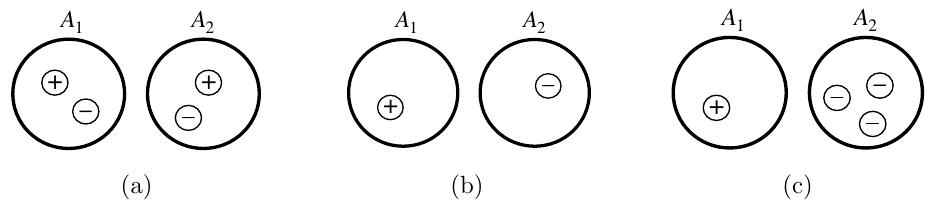
Figure 2. (a) Charge neutral operators in region A 1 [ A 2 : a 2 A 1 (cid:10) A 2 . (b) A bi-local intertwiner in A 1 [ A 2 : I 12 2 A 12 . (c) Local intertwiners, or charged operators in A 1 [ A 2 that belongs to the global algebra F 1 (cid:10) F 2